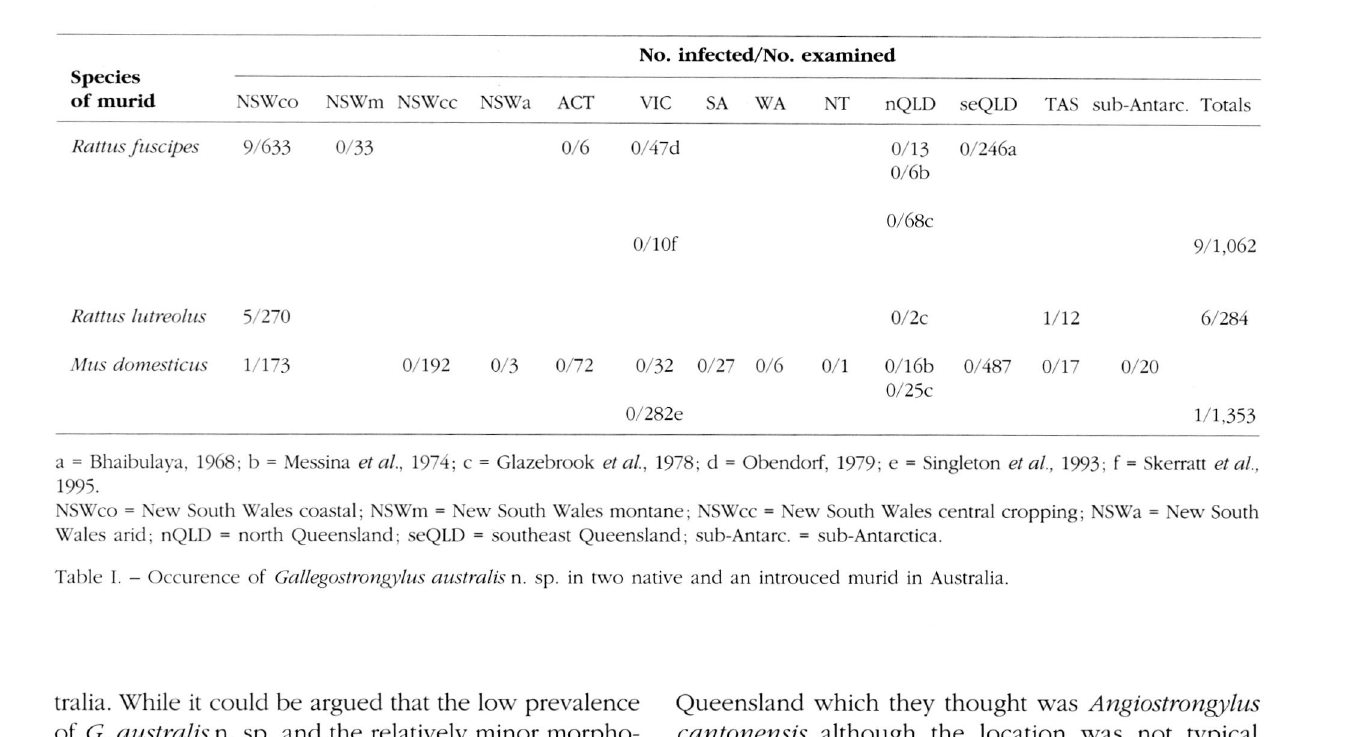
Table I. - Occurence of Gallegostrongylus australis n. sp. in two native and an introuced murid in